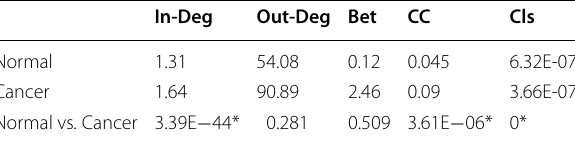
Table 2 Toplogical comparison of stage‑specific GRNs